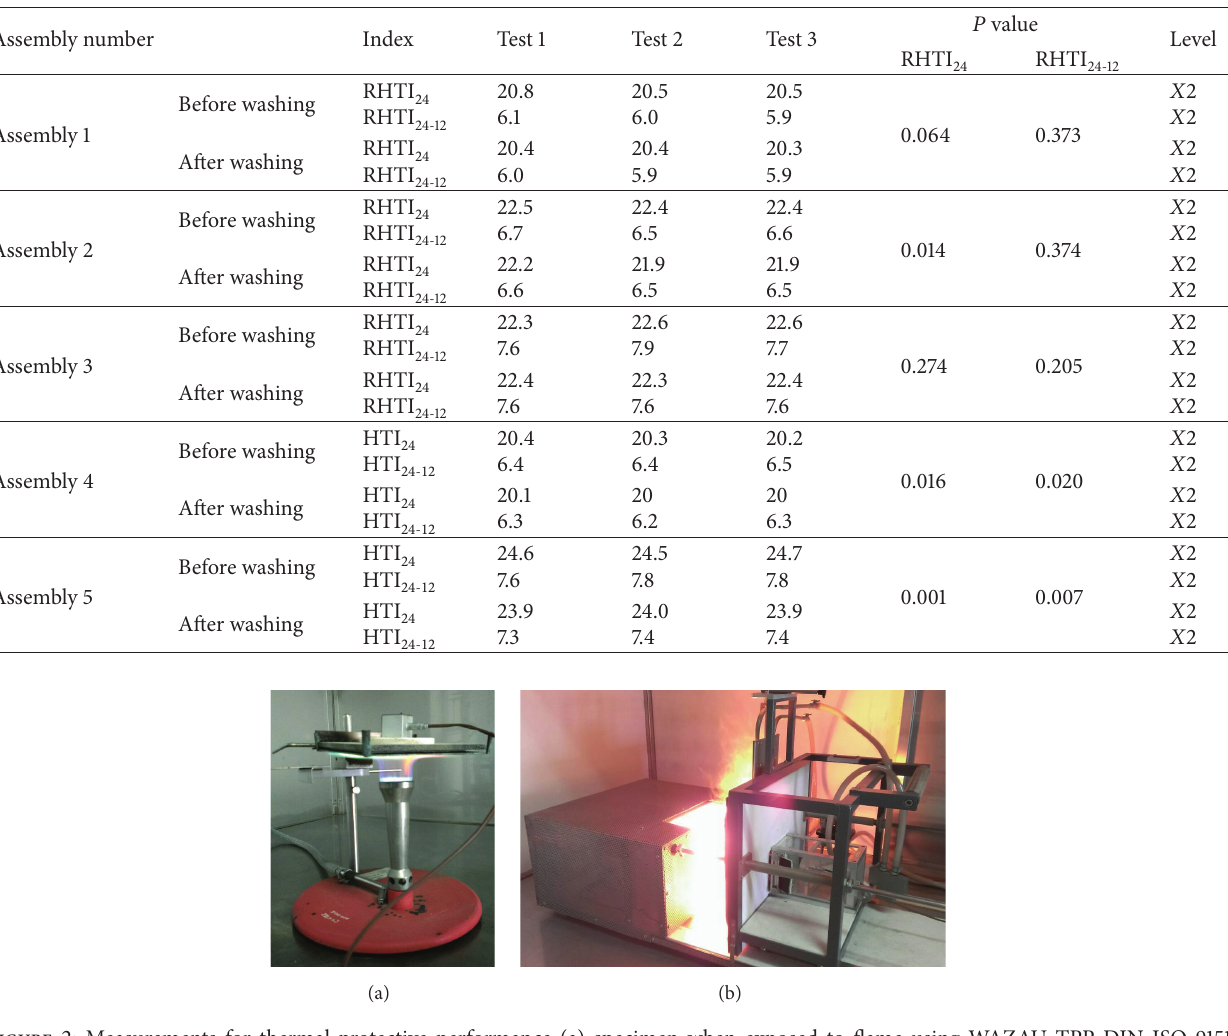
Table 3: Heat transfer-radiation test results of multilayered fabric assemblies.